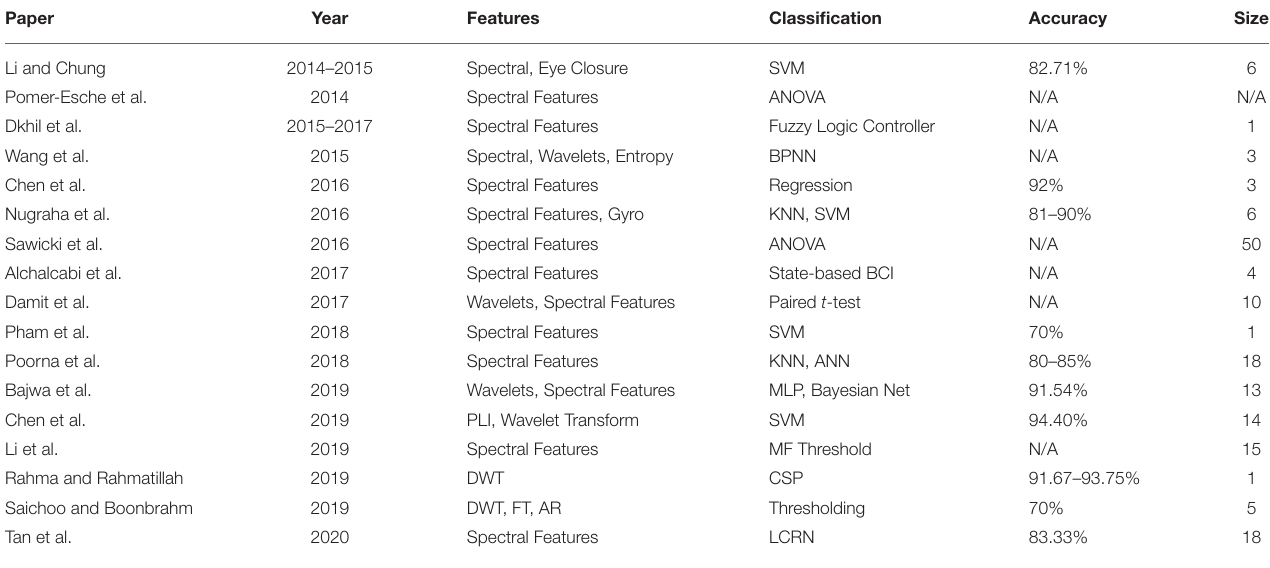
TABLE 6 | Emotiv Insight, Flex, and Epoc